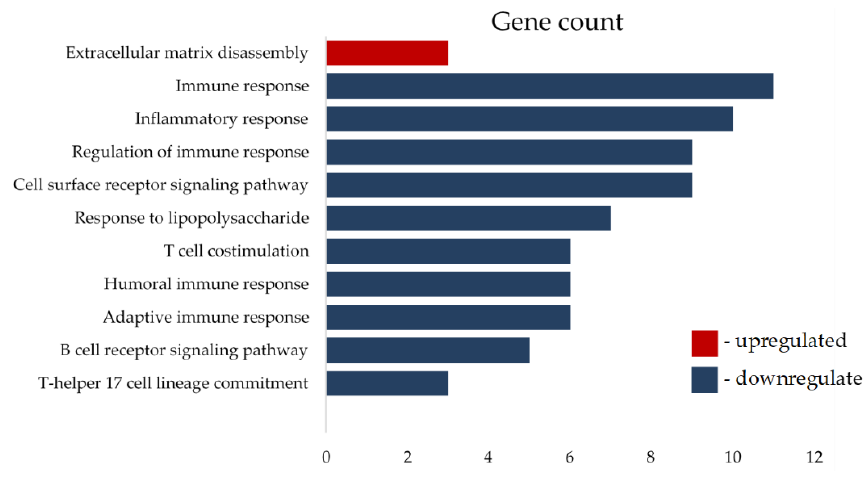
Figure 6. Significantly affected biological processes in BC patients with ER α 36high tumor stroma fibroblasts depicted as the number of genes involved in a particular process.